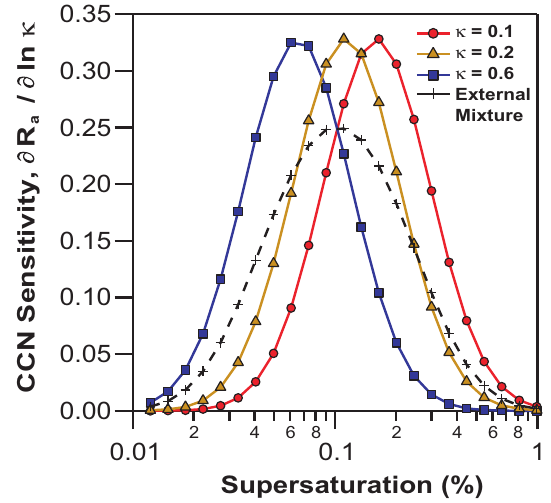
Fig. 9. Sensitivity of R a to κ as a function of superaturation. Solid traces were computed assuming an internal mixture and constant values of κ , while the dashed trace represents an external mixture of 50% inorganic aerosol ( κ =0.6) and 50% organic aerosol ( κ =0.1), by number.